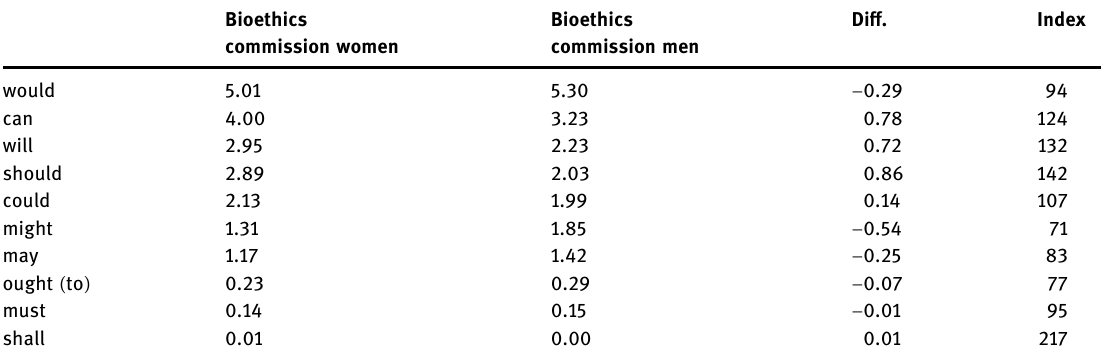
Table 6: Word list extract: comparison of frequency individual modal auxiliary use as per cent of total tokens ( normalised, n = 1,000 ) by commission women vs men